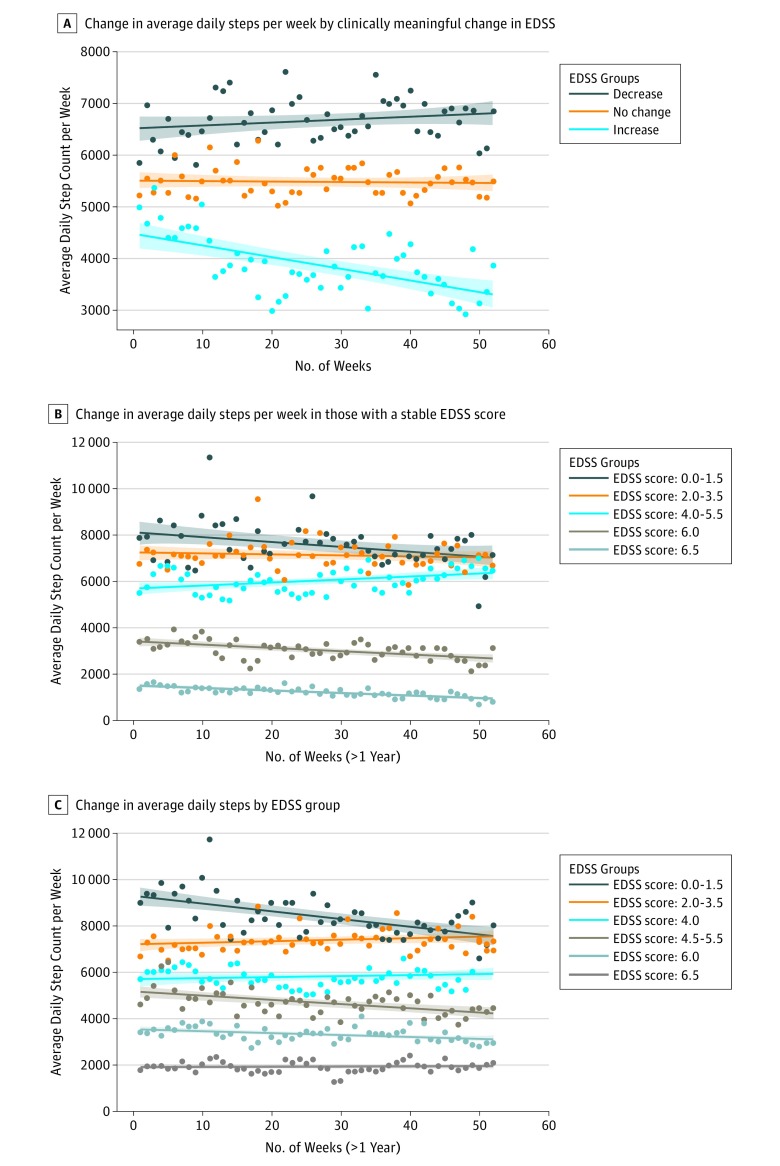
Change in Average Daily Step Count Stratified by Expanded Disability Status Scale (EDSS) ScoreA, Change in continuous average daily step count per week during a 1-year period, stratified by clinically meaningful change in EDSS score. B. Change in average daily step count per week during a 1-year period among individuals with a stable EDSS score (groups with EDSS scores of 4.0 and 4.5-5.5 were combined to achieve an adequate sample size). C, Change in average daily step count per week during the 1-year study by EDSS group. In each panel, the shaded area represents the 95% CIs for the regression line, and each point reflects the daily step count averaged per week (using weighted means) for individuals who had clinically meaningful worsening, improvement, or no change in EDSS score during a 1-year period (52 weeks).